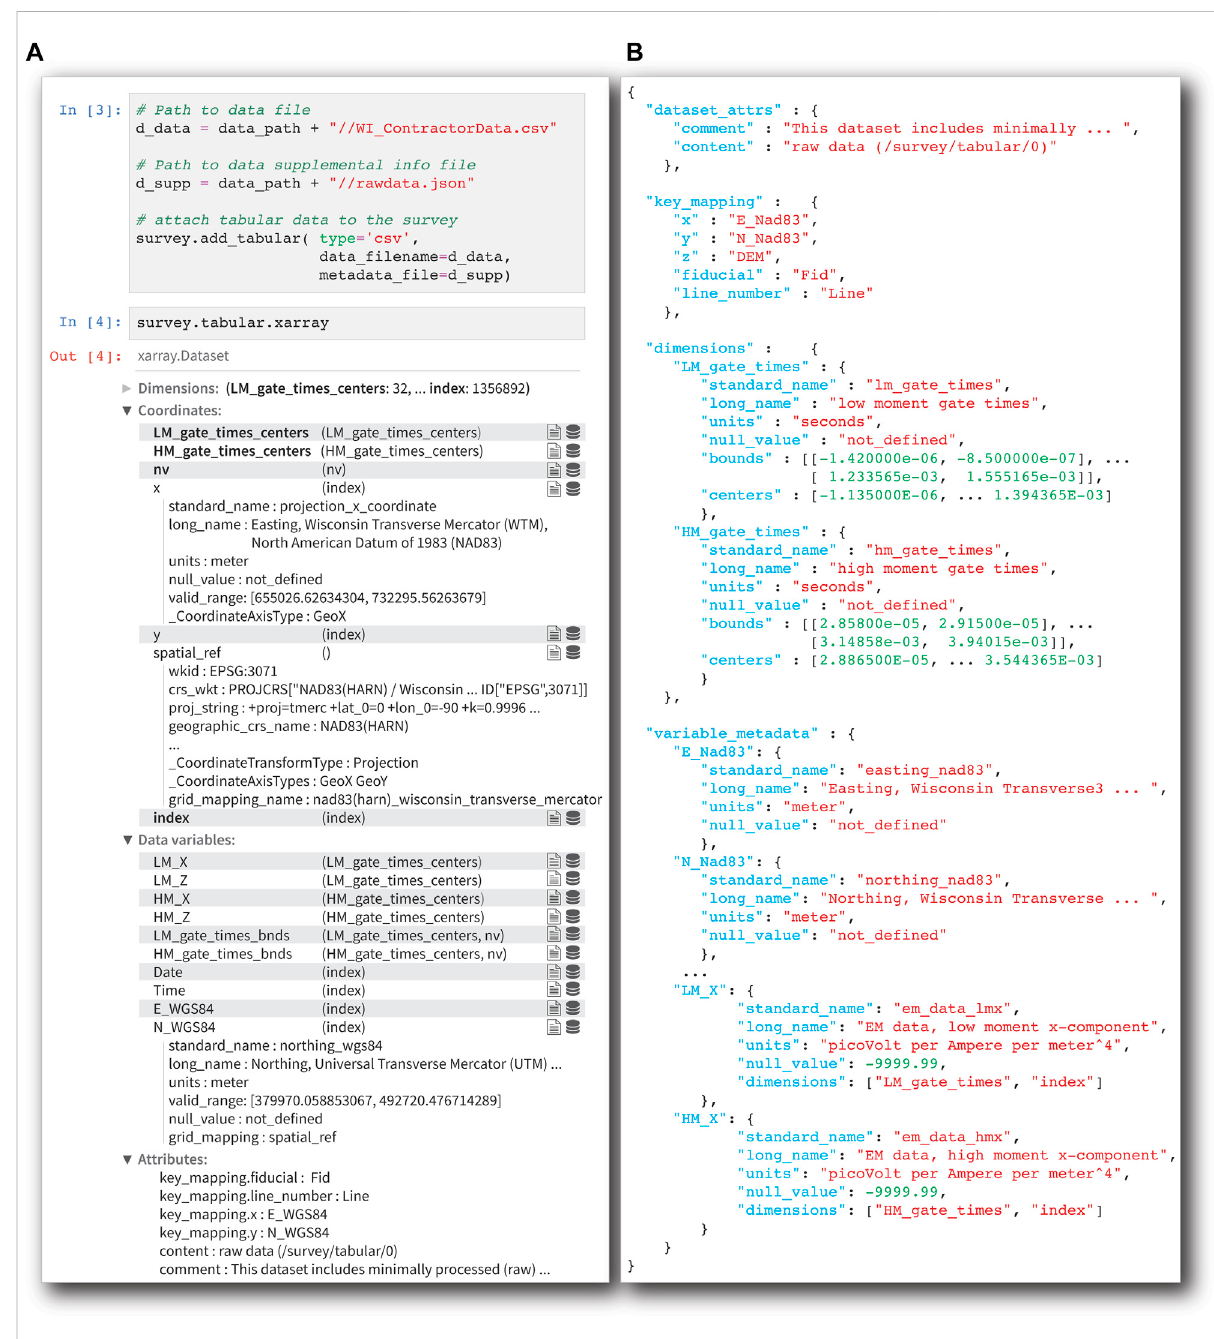
FIGURE 4 Attaching a Tabular group to a Survey . (A) The “ add_tabular ” method is used to add a Tabular Dataset to Survey . (B) The Dataset attributes, coordinate “ key_mapping, ” variable-speci fi cmetadata,andanysecond-dimensionvariablesarepassedthrougharequiredJSON fi lewhenattaching the Tabular